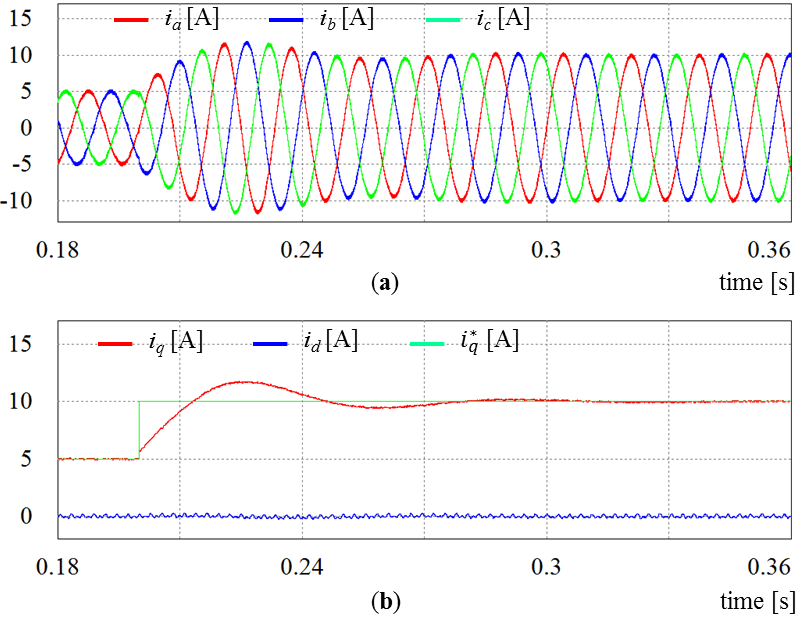
Figure 16. Transient responses of the proposed current control scheme under the distorted grid voltages: ( a ) phase-currents; and ( b ) q- axis and d- axis currents.